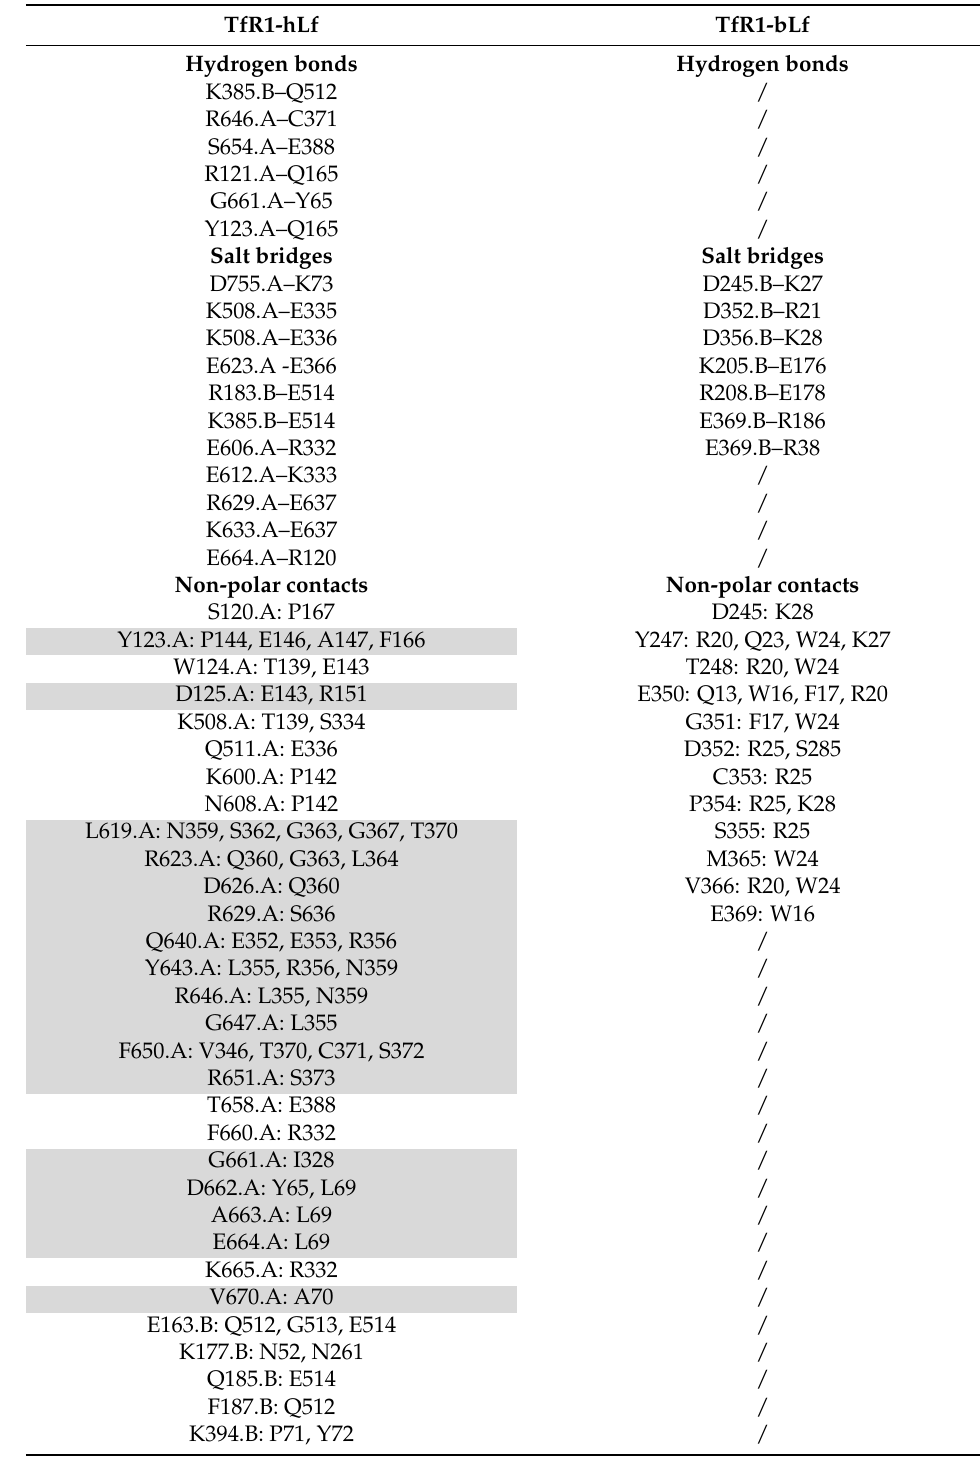
Table 2. Hydrogen bonds, salt bridges and non-polar interactions established between transferrin receptor 1 (TfR1) (monomer A and B) and human lactoferrin (hLf) or bovine lactoferrin (bLf). TfR1 residues highlighted in grey are also contacted by Tf in the Tf-TfR1 crystallographic structure (PDB ID: 3S9L).